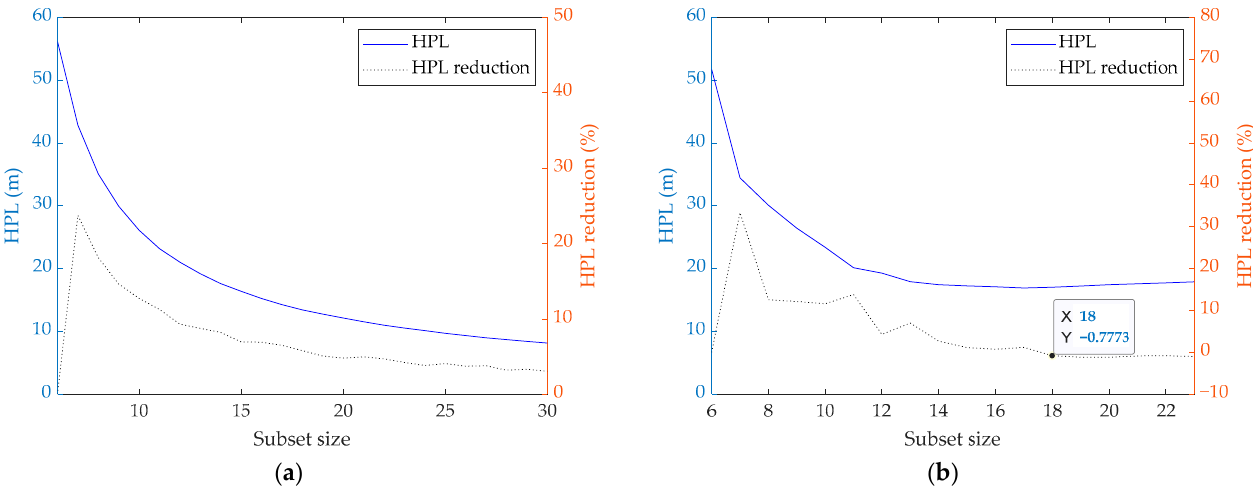
Figure 2. Minimal HPL value and HPL reduction to the former for each size subset. ( a ) In the ideal scene; ( b ) In the practical scene.